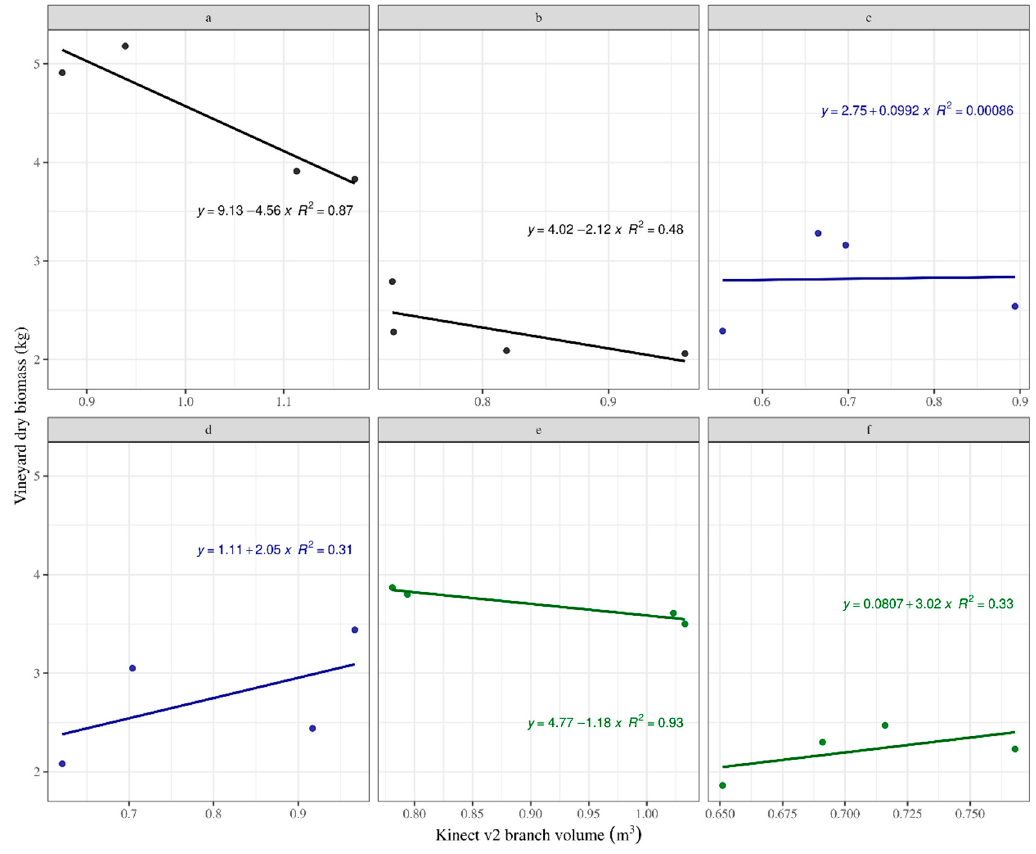
Figure 7. Kinect branch volume versus vineyard dry biomass including effect of treatment.